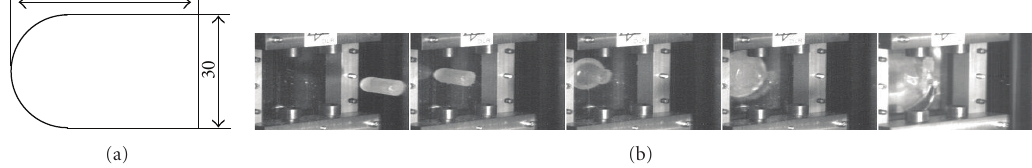
Figure 3: (a) Geometry of artificial bird impactor (in mm) and (b) high-speed video images of bird strike test (by